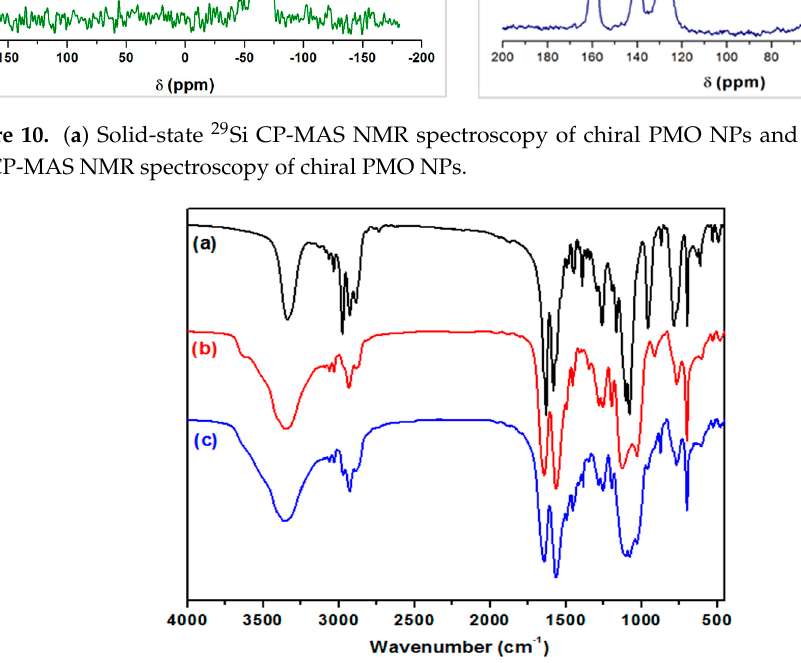
Figure 11. FTIR analysis of ( a ) chiral ligand ( 4 ), ( b ) chiral PMO NPs, and ( c ) chiral magnetic PMO NPs.